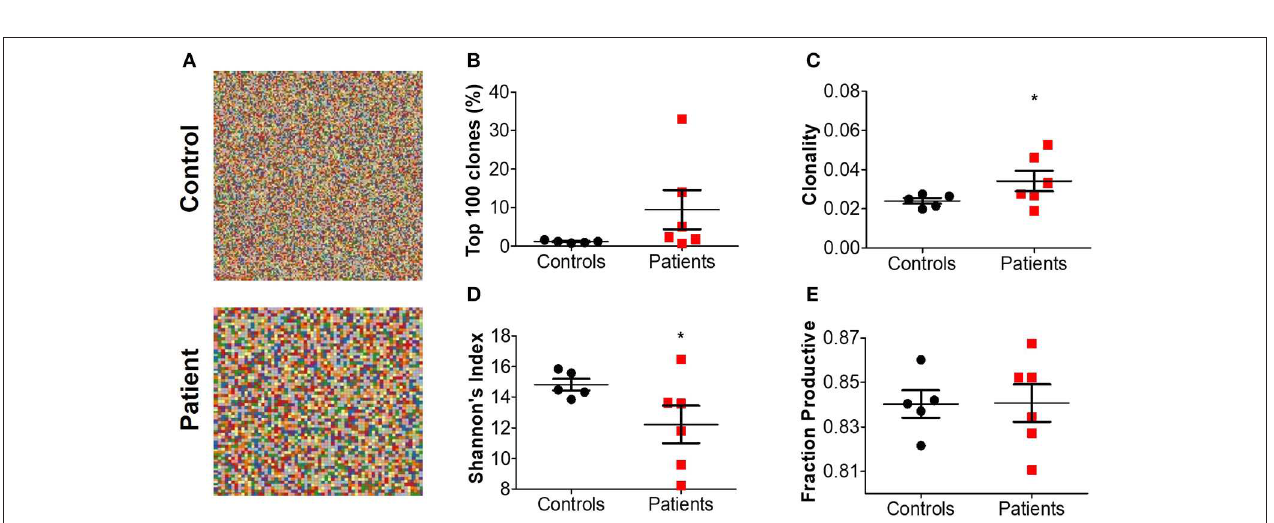
FIGURE 5 | Increased clonality of BCR repertoire in blood from patients with IL10 signaling defects. (A) Representative Treemaps of entire BCR repertoire in a representative control (C1) and IL10R-deficient patient (P2). (B) Cumulative percentage of the 100 most abundant clones from the total repertoire, (C) calculated clonality, (D) Shannon’s diversity index, and (E) fraction productiveness in control and patient groups. Bars represent mean ± SEM.